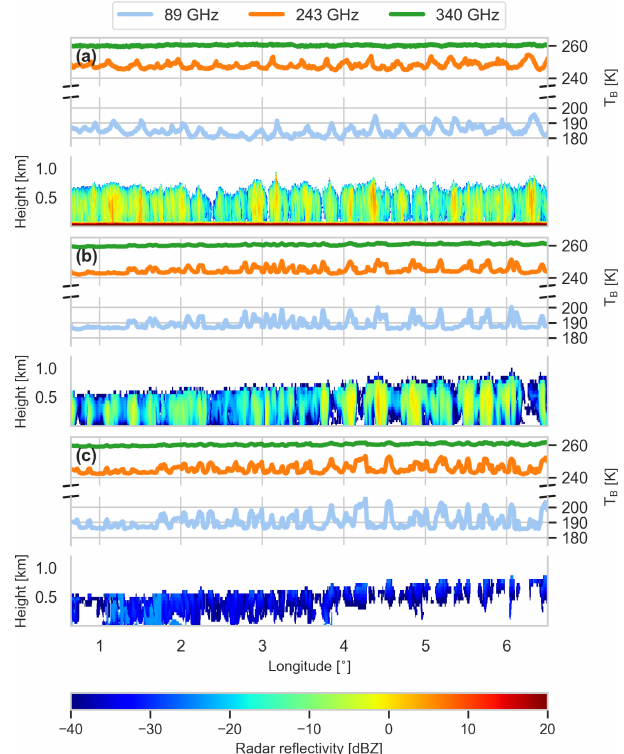
Figure 5. Radar reflectivity at 94GHz and T B at 89GHz (blue) with horizontal polarization as well as at 243 (orange) and 340GHz (green) with mixed polarization as measured by the MiRAC instru- ment (a) during a 30min flight section in the west–east direction over the Fram Strait on 25 May 2017. Simulated radar reflectivity and T B with ICON-LEM and PAMTRA after improvements made to the microphysical scheme in ICON-LEM (b) and before (c) . Note that the radar and 89GHz measurements were performed under an angle of 25 ◦ backwards.